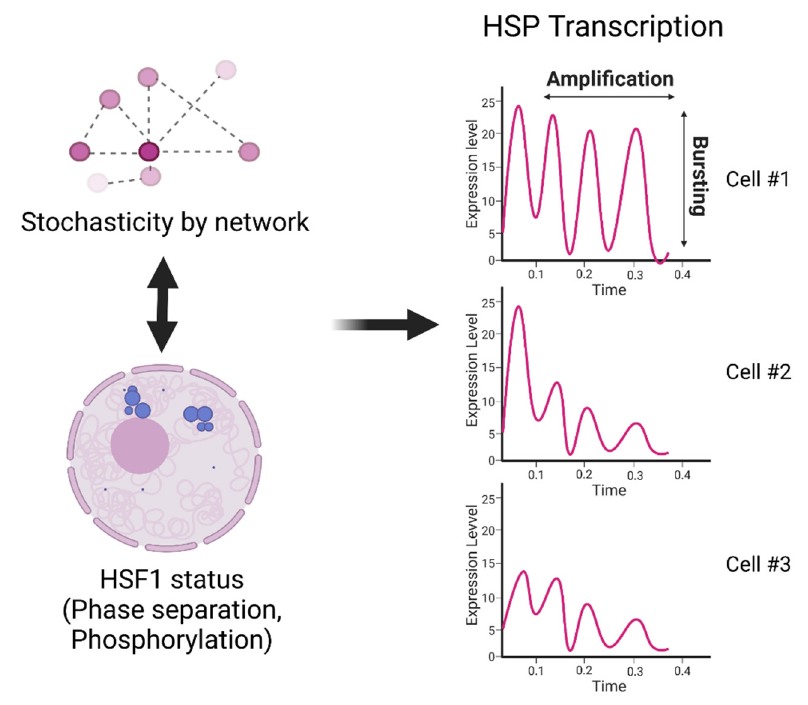
Figure 2. Hypothetical model of heterogeneous activation of HSP transcription. Stochastic cellular states can be generated by intercellular communications within the network. These communications and other mechanisms, such as liquid–liquid-phase separation at HSP gene loci, initiate heteroge- neous HSF1 states between cells. These differences may cause differences in the dynamics of HSP transcription between cells through transcriptional bursting and amplification.